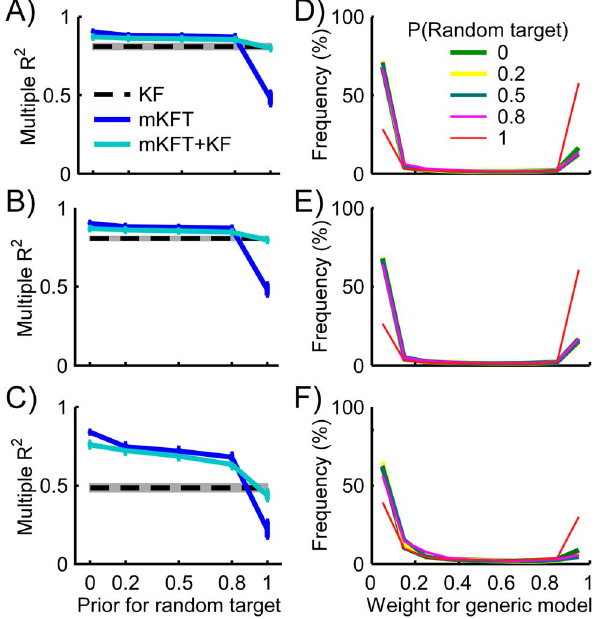
Figure 4. Accuracy of the decoding models with varying target uncertainties for A) C6; B) C5; and C) C4 simulated injury levels. d)-f) Corresponding histograms for the weights assigned to the generic model, over the course of all reaches, in the combined mixture case. The histograms are very similar where the prior assigned to the random target is less than 1. Error bars and shading represent standard